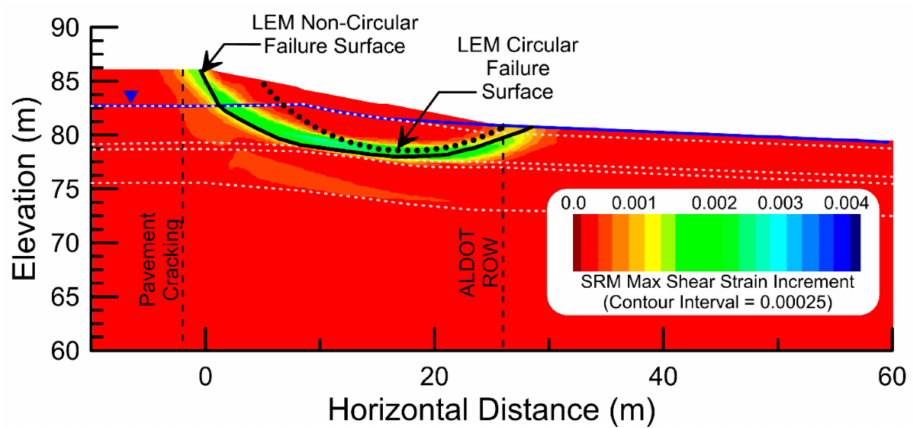
Figure 8. Maximum shear strain interval contours (zoomed in on failure surface location) from initial peak undrained ( s u,pk / σ (cid:48) v = 0.21) SRM analysis with critical noncircular failure surface from LEM shown as solid black line and critical failure surface from LEM with circular surfaces shown by dotted black line. Locations of ALDOT ROW and pavement cracking shown by dashed black lines. Soil layer boundaries (Figure 2) shown by dotted light grey